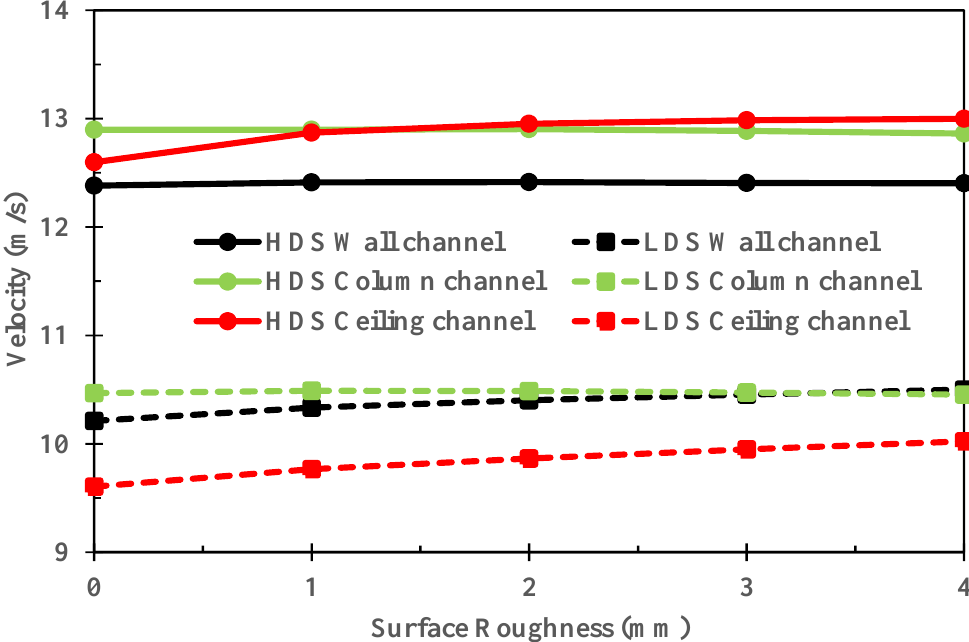
Figure 10. The effect of the brick surface roughness on the air velocity in the different kiln channels for the LDS and HDS.